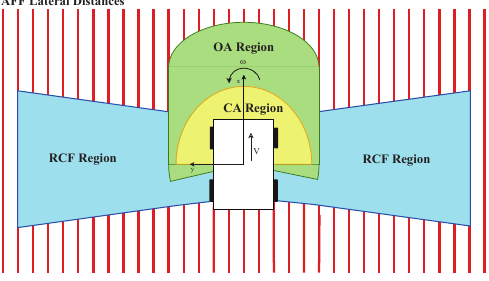
Figure 7. A region is defined for every control layer around the mobile platform. They are described by lines parallel to the mobile platform’s x-axis, a circular shape with a certain radius from the center of the platform or limited by an angle θ from that same center point. The described shapes provide the input for the acoustic flow models to generate masks within the eneryscapes of each sonar sensor.